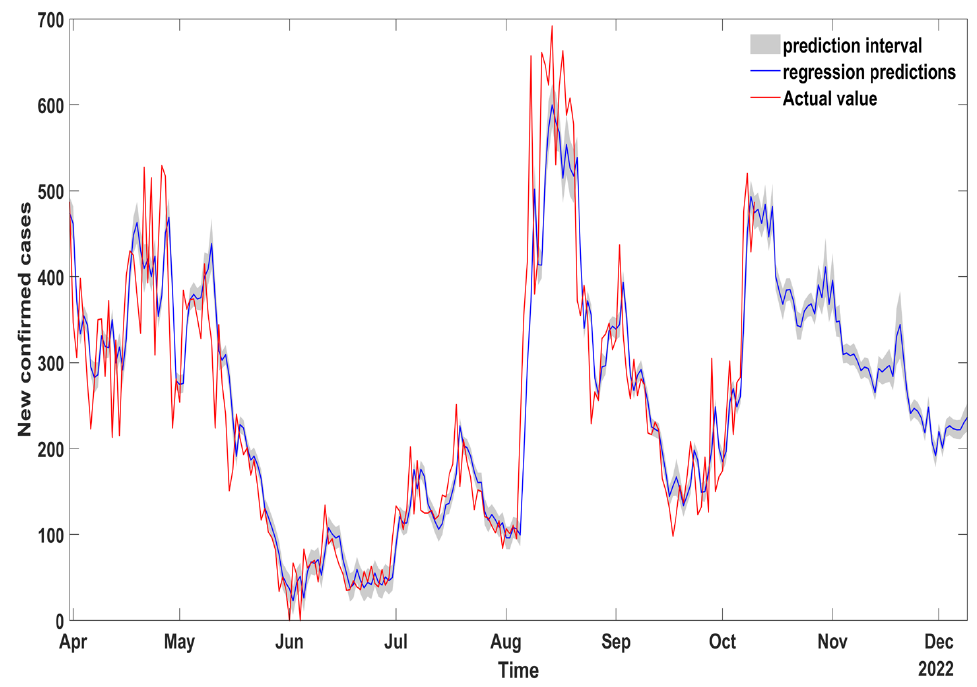
Figure 10. Future